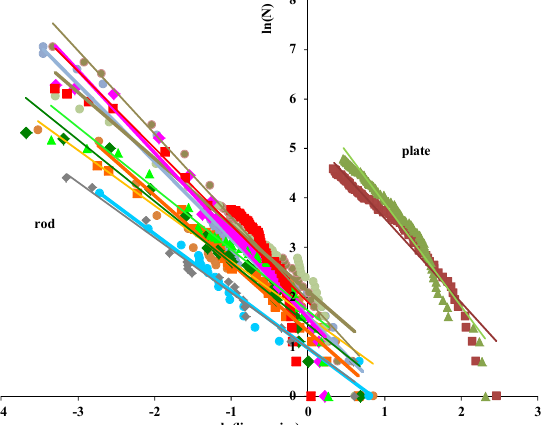
Figure 8: Double logarithmic plot of the cumulative distribution function for a plate and a rod (different colors correspond to different